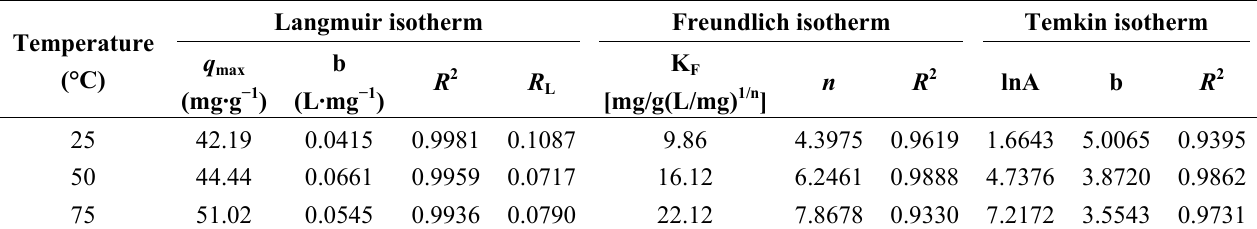
Table 1 summarized the isotherm data of Langmuir, Freundlich and Temkin model for the adsorption of Ni(II) onto peh-g-opefb. Table 1. Langmuir, Freundlich and Temkin isotherm constants, maximum adsorption capacities q , and correlation coefficients R 2 for nickel (II) adsorption at various max